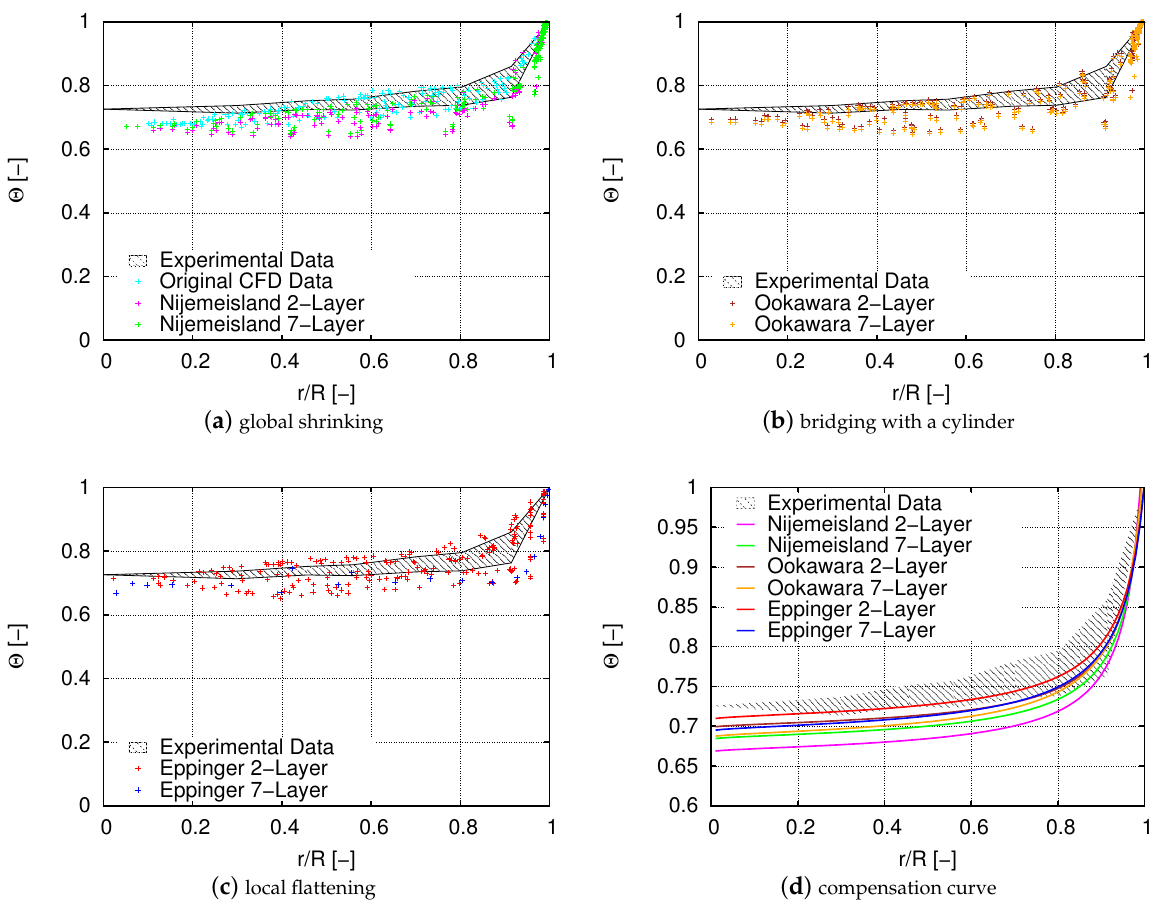
Figure 6. ( a – c ) Comparison of temperature data at the outlet of the packed bed for different contact point methods and experimental data for Re = 986; ( d ) best-fit curves based on the results from ( a – c